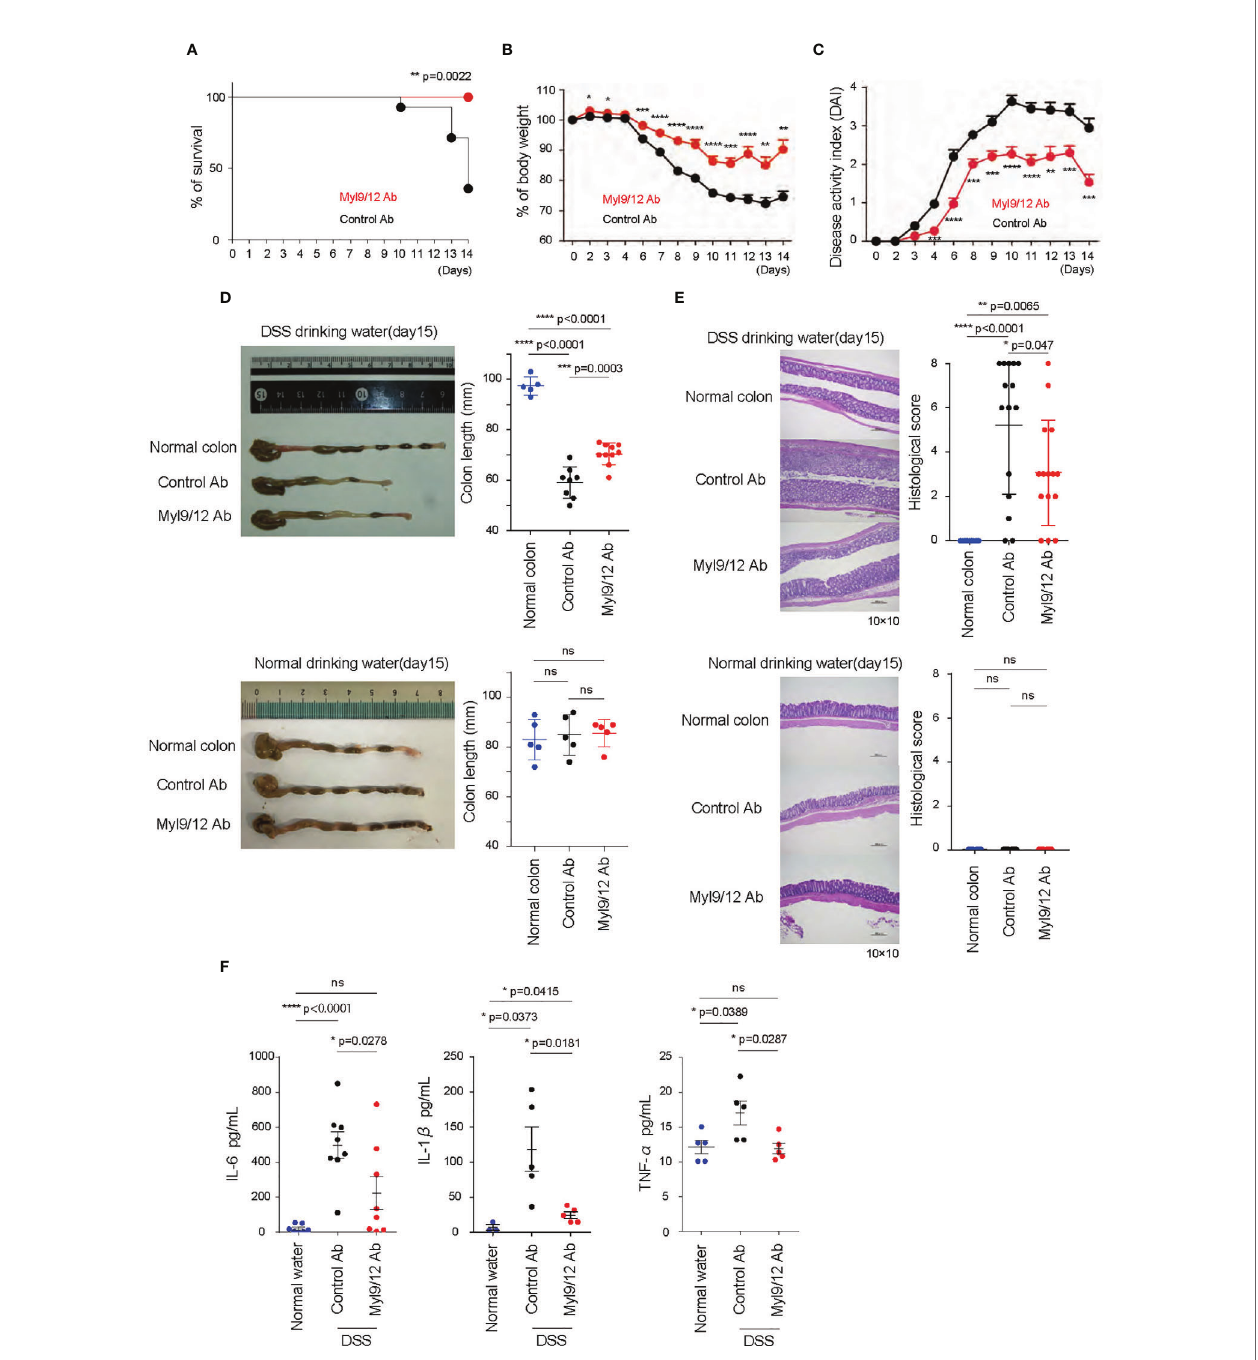
FIGURE 2 | The administration of anti-Myl9/12 Ab ameliorated DSS-induced colitis. (A – C) The rate of survival (A) , percent change of body weight on each day relative to those on day 0 (B) , and disease activity index (DAI) (C) of the DSS-induced colitis model mice treated with either anti-Myl9/12 Ab or Control Ab (n = 10 per group); *p < 0.05; **p < 0.01; ***p < 0.001; ****p < 0.001. (D) A representative image showing the gross appearance of the colon from the DSS-induced colitis model mice (upper) and the mice drinking normal water (bottom) treated with either anti-Myl9/12 Ab or Control Ab. Each image included the image from a healthy mouse (Normal colon). The colon length from the mice either at the time of death or on day 15. ***p < 0.001; ****p < 0.001. (E) Hematoxylin and eosin (HE) staining of the colon from a healthy mouse or DSS-induced colitis model mice treated with either anti-Myl9/12 Ab or Control Ab (left). The histological score is determined based on the changes described in Supplementary Table 2 . *p < 0.05; **p < 0.01; ****p < 0.001. (F) IL-6, IL-1 b , TNF a production in the plasma from DSS- induced colitis model mice treated with either anti-Myl9/12 Ab or Control Ab. *p < 0.05; ****p < 0.0001. ns, not signi fi